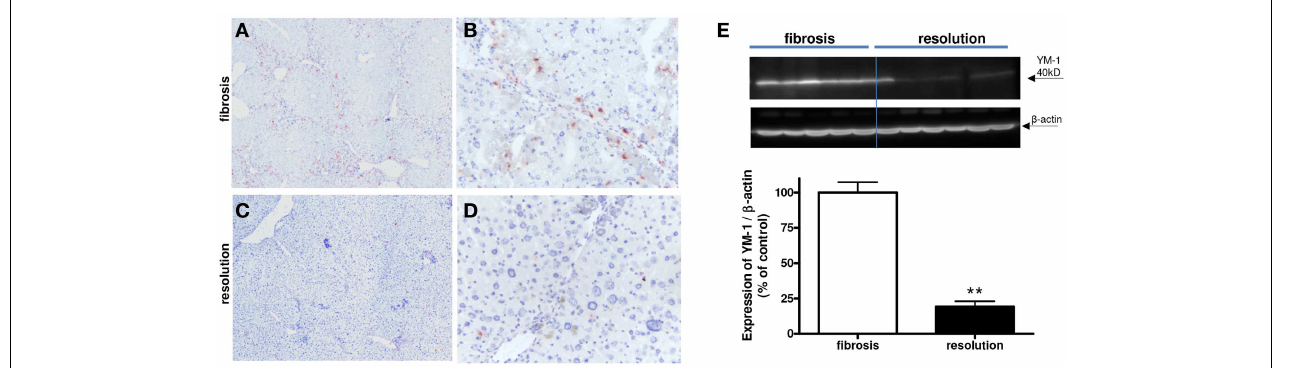
overview [ (A,C) magnification 40 × ] and close up [ (B,D) magnification 200 × ]. (E) Western blot quantification ofYM-1 expression in fibrosis versus resolution. ** p < 0.01. N =